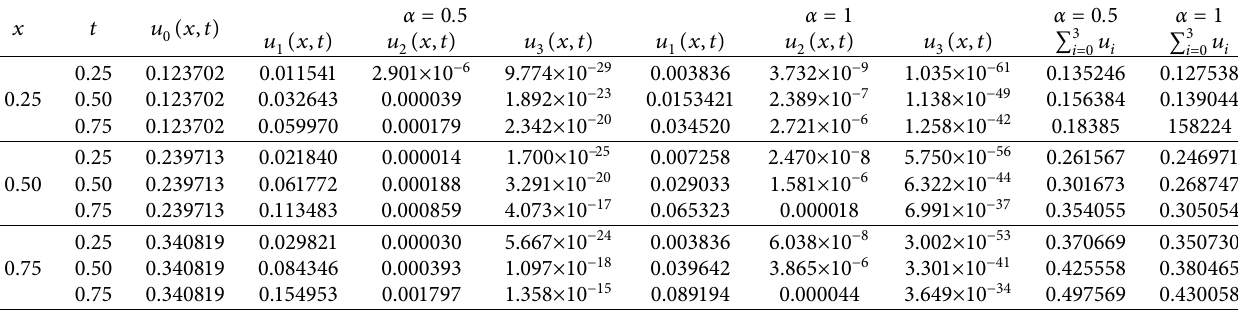
� q � 0 . 5 , 1 and α � β � 0 . 5 for Example 2. 1 2